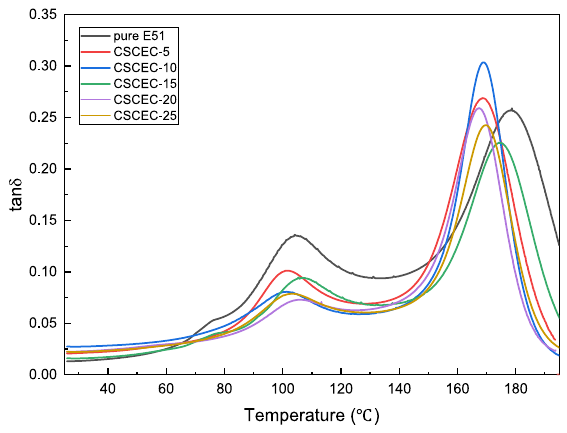
Figure 6. Tanδ-Temperature curves of the composites.